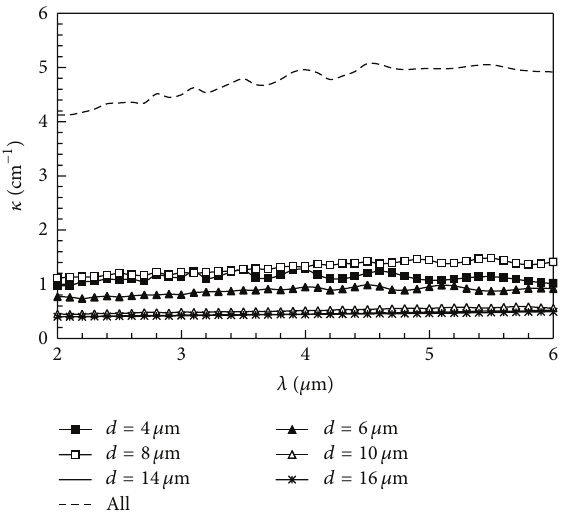
Figure 6: Calculated absorption coefficient of Al 2 O 3 particles with Mie